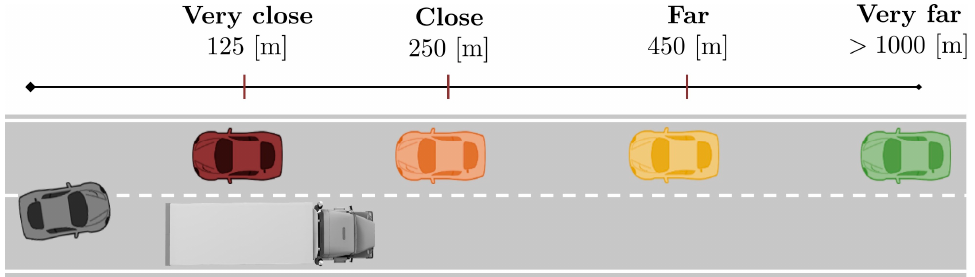
Figure 5. Upcoming vehicle events at four pre-defined distances.